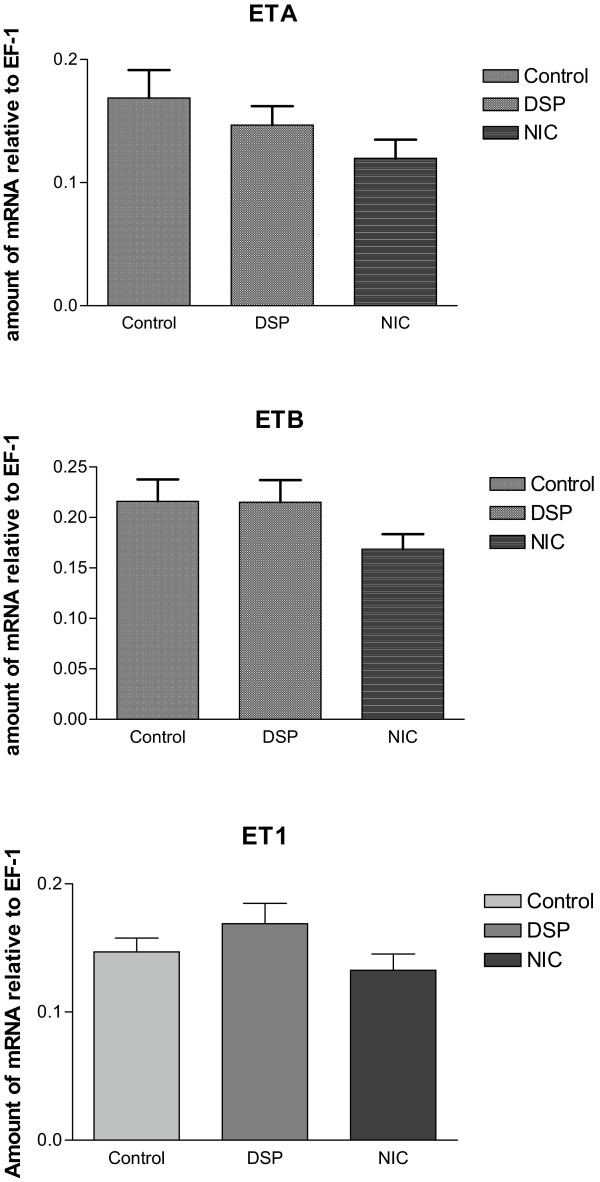
mRNA expression of ETA receptors (A), ETB receptors (B) and ET-1 in the bronchi. The mRNA expression of ETA and ETB receptors and ET-1 in the bronchi was quantified by means of real-time PCR. Each data point was derived from results for at least 3 segments. No differences in the expression level after DSP or nicotine treatment were found as compared with controls (DMSO), (p > 0.05).